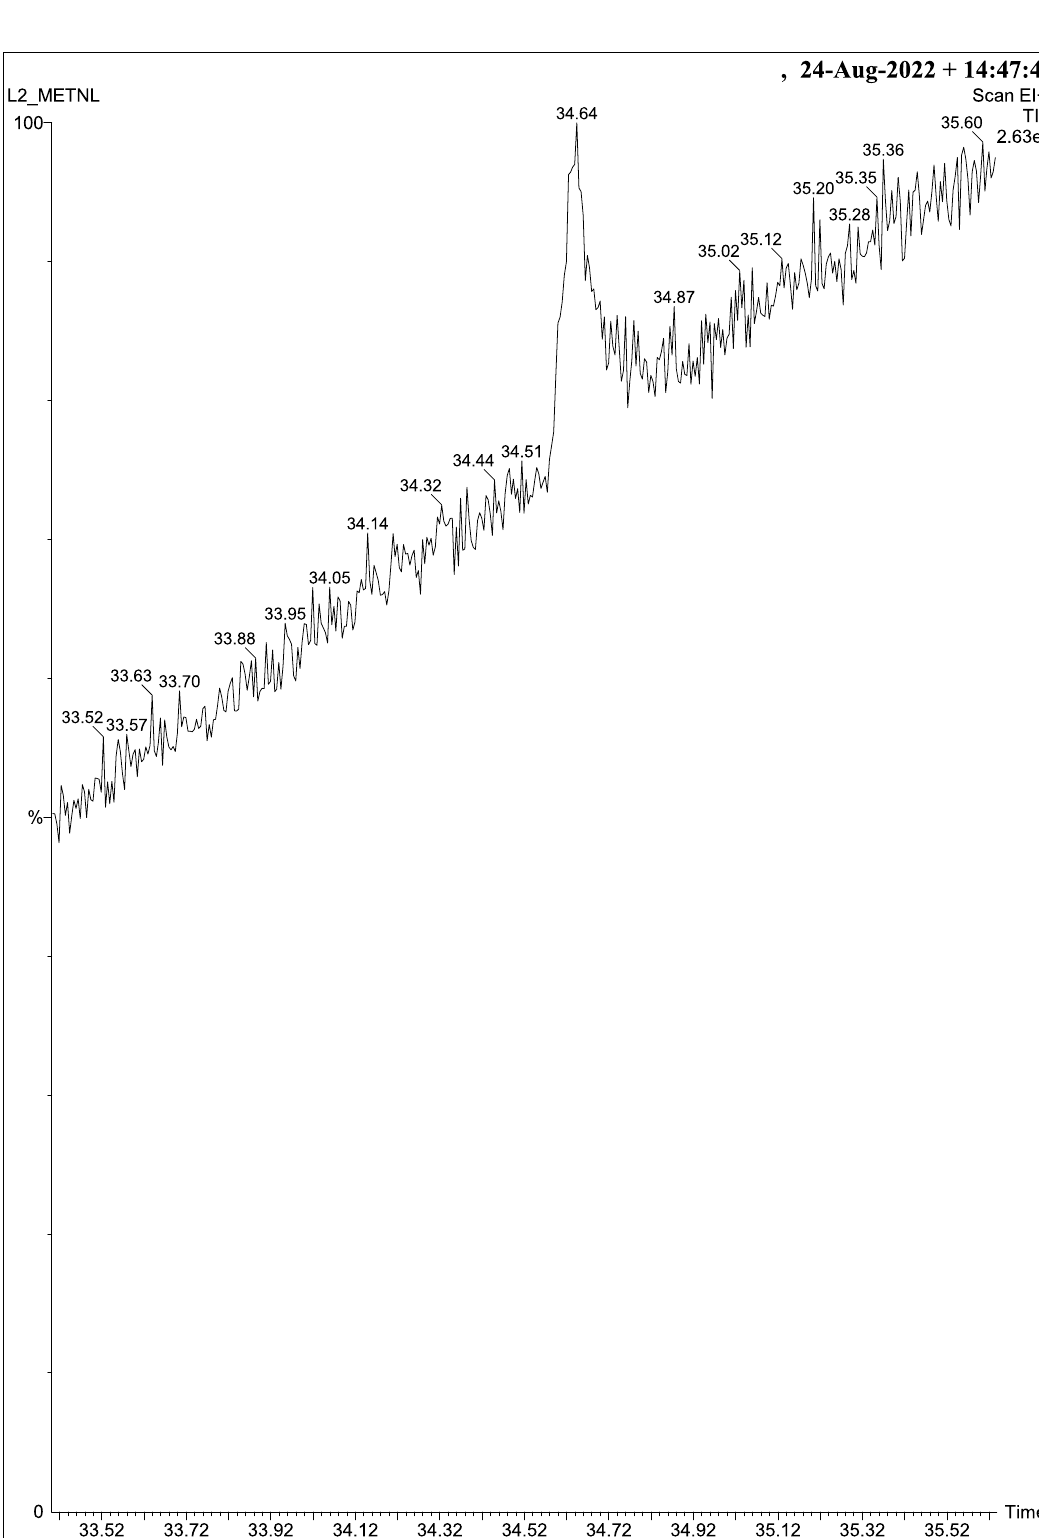
Fig. 13 GC‑MS chromatograms of methanol extract of P.